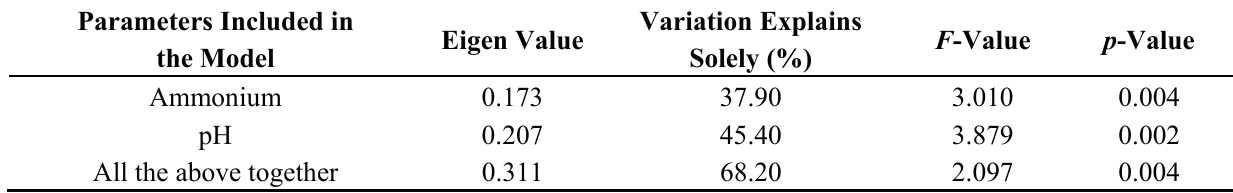
Table 3. Eigenvalues, F -values, and p -values obtained from the partial RDAs testing the influence of the significant parameters on the fungal community composition. Variation Parameters Included in Eigen Value the Model